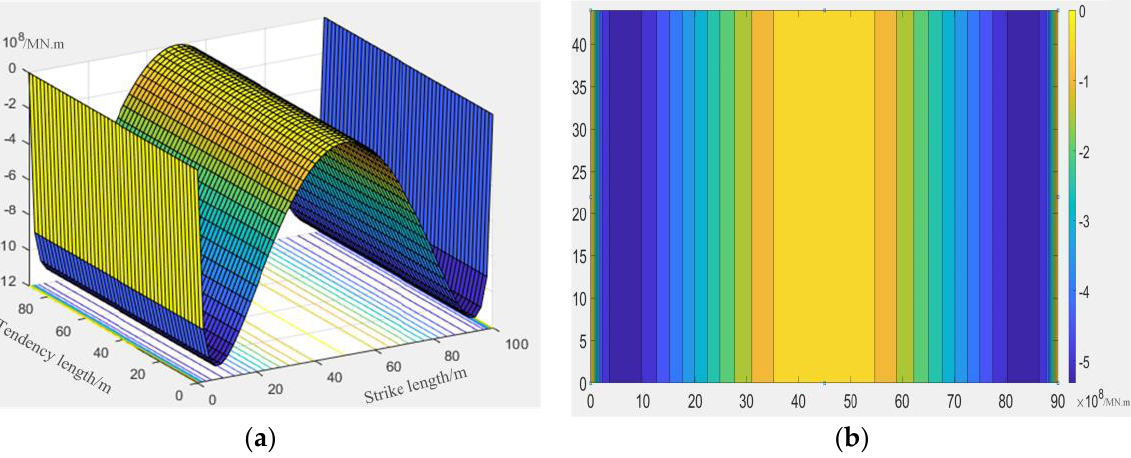
Figure 13. Three-dimensional contour map of internal force distribution of structural arch. ( a ) Struc- tural arch bending moment diagram; ( b ) Structural arch stress contour diagram.